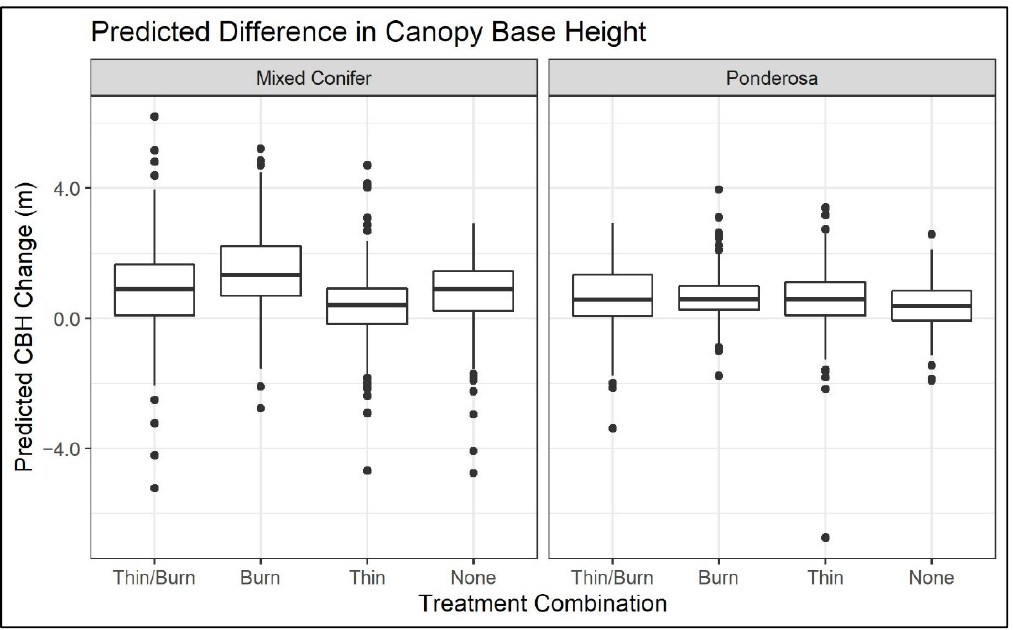
Figure 6. Predicted change in CBH in all sample units; ponderosa pine and dry mixed-conifer forest types on the Malheur National Forest near John Day, OR, USA.